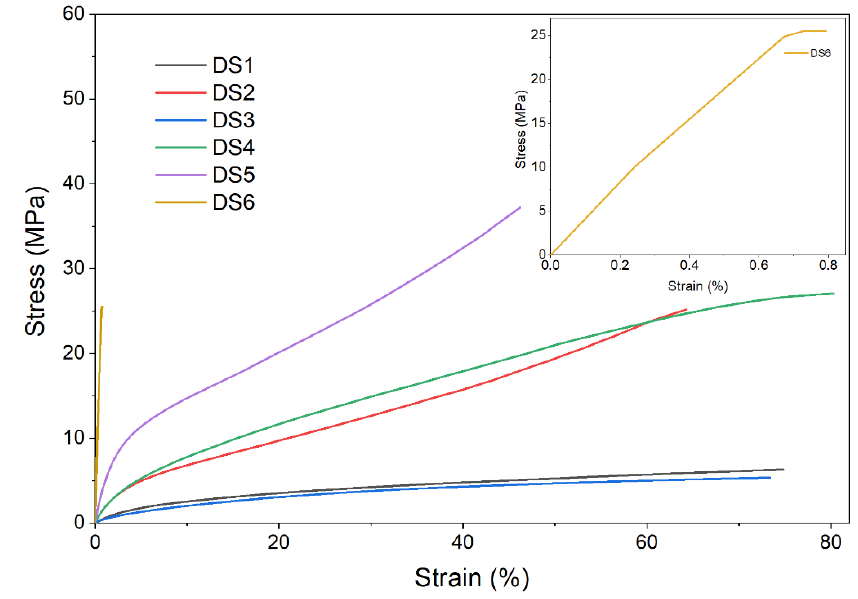
Figure 4. Stress – strain plots for the nanocomposite films. Figure 4. Stress–strain plots for the nanocomposite